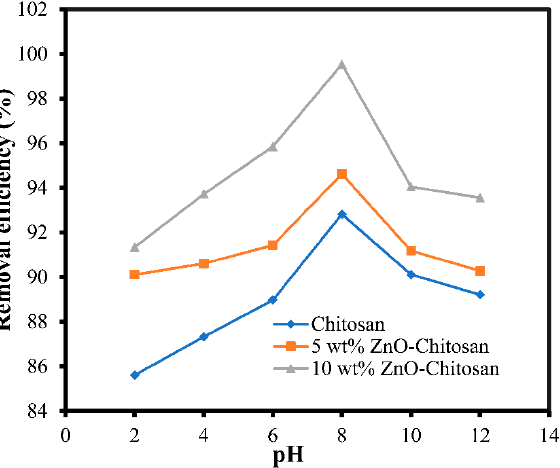
Figure 7. Effects of pH for the dye adsorption onto the chitosan and the nanocomposites.